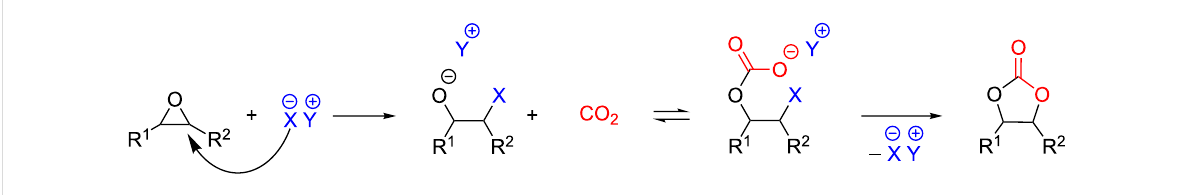
Scheme 3: Proposed mechanism for the formation of cyclic carbonates mediated by an ammonium salt.